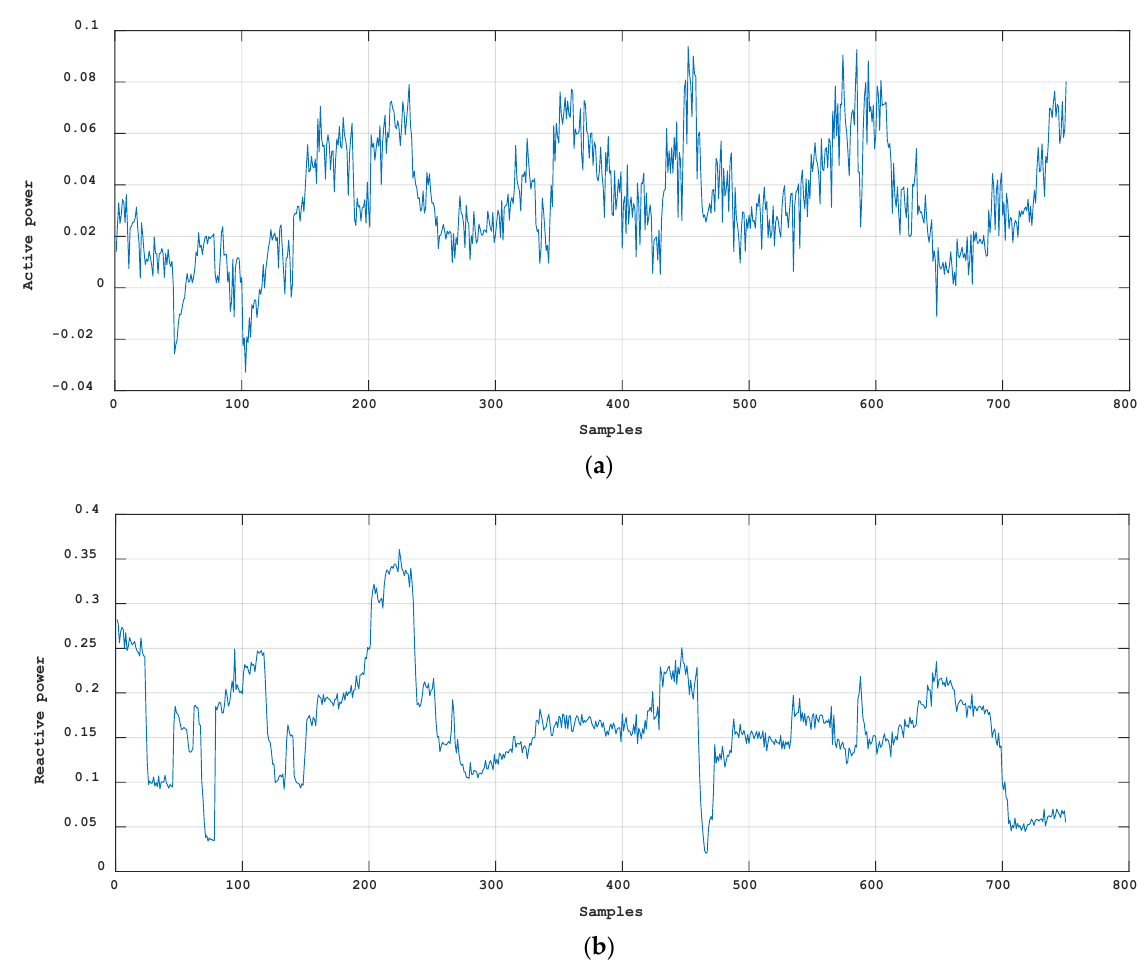
Figure 3. The variation in the active power ( a ) and reactive power ( b ) in the railway power supply substation.